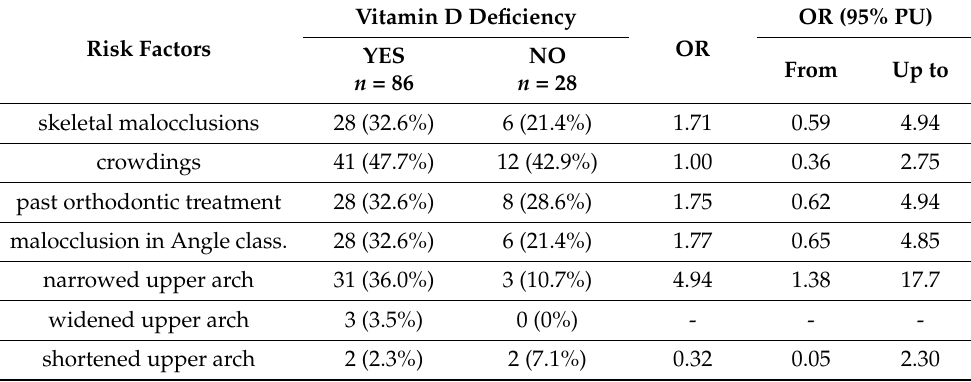
Table 4. Comparison of qualitative characteristics of patients differing in vitamin D3 levels and test